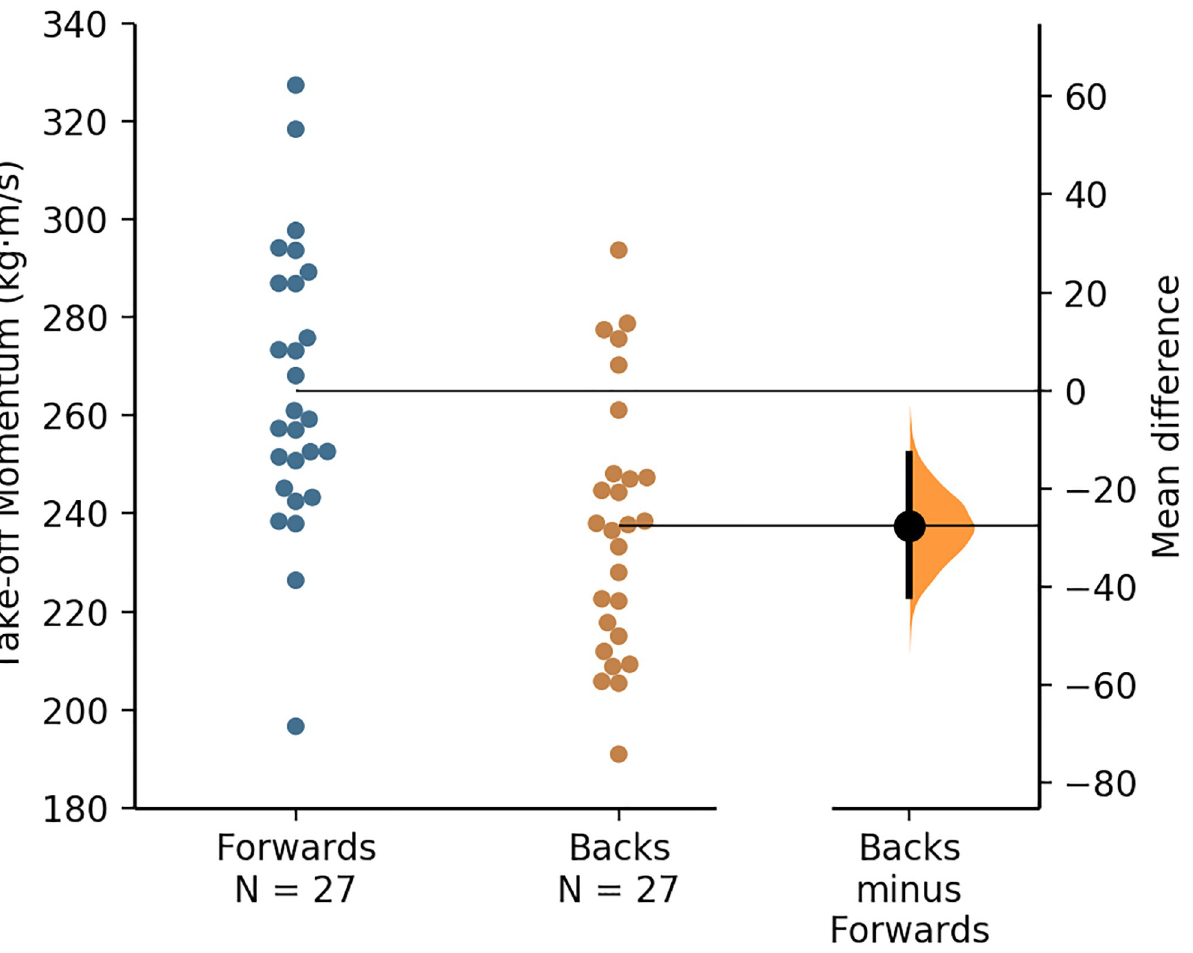
Fig 3. A Gardner–Altman plot of the forwards’ and backs’ take-off momentum data, with the mean and mean difference for and between each positional group,